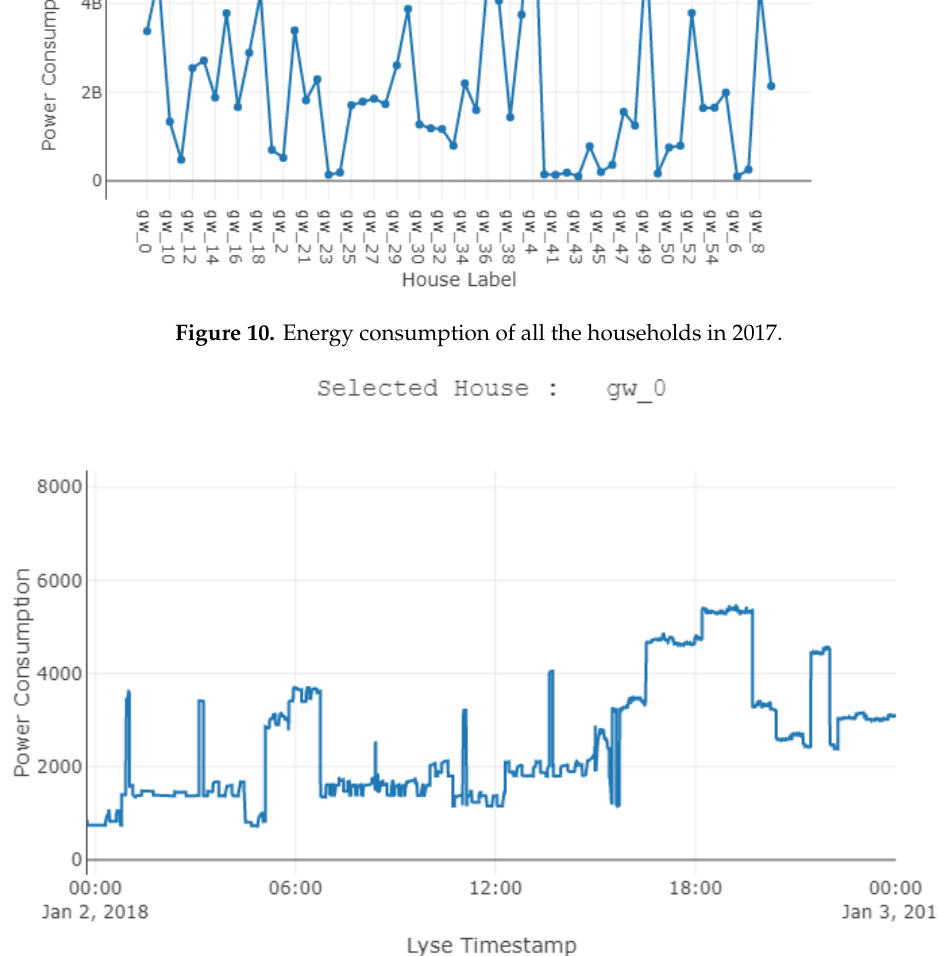
Figure 11. Hourly energy consumption of house labeled “gw_0”.